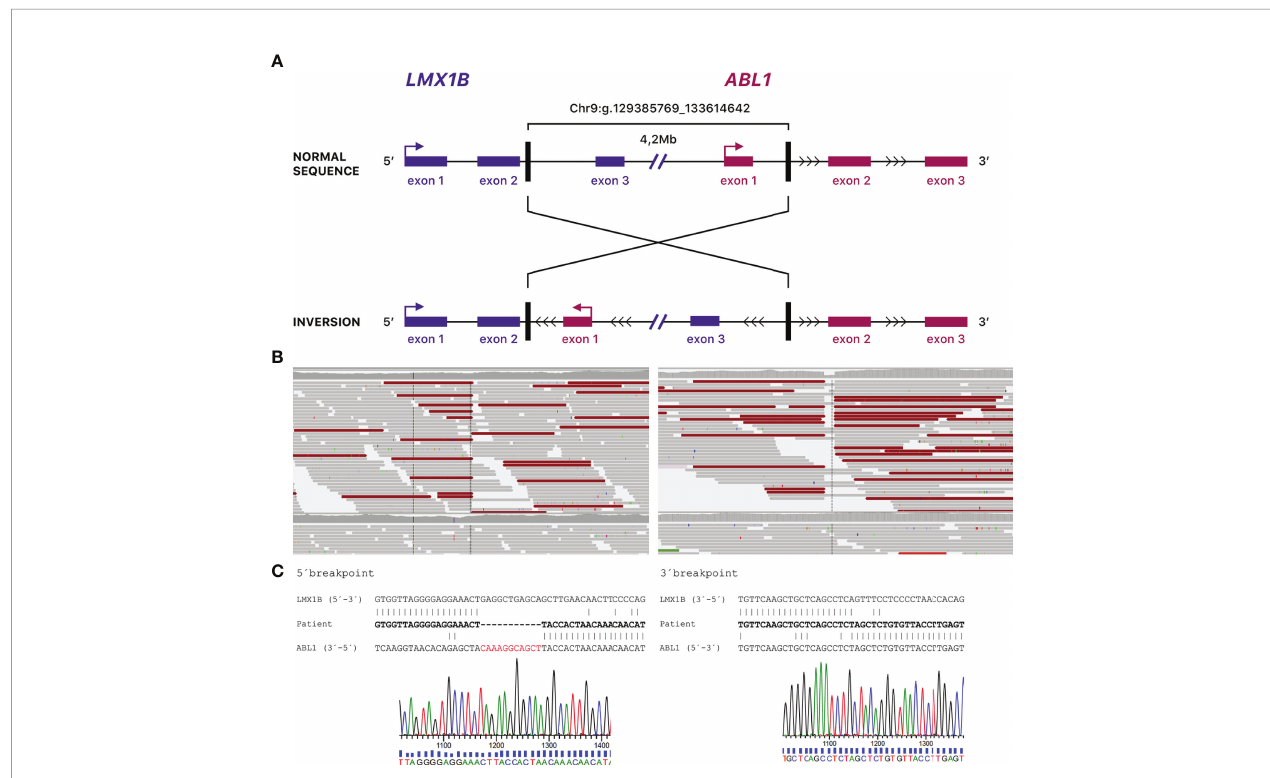
FIGURE 2 | (A) Schematic depiction of the inverted region. Vertical lines show the breakpoints. Note that the fi gure is not drawn to scale. (B) Whole genome sequencing data of the breakpoints of the inversion. (C) Schematic presentation of the breakpoint junction between intron 2 in LMX1B and intron 1 in ABL1 and sequence traces over the breakpoint junctions.